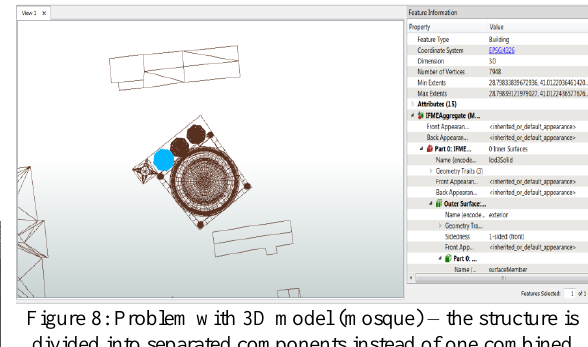
Figure 8: Problem with 3D model (mosque) – the structure is divided into separated components instead of one combined